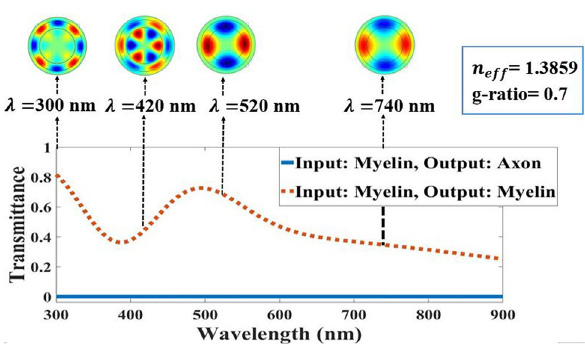
Figure 6. Light transmission spectra in output of the axon and myelin at g-ratio = 0.7 with guided modes in myelin sheath in 300 nm, 420 nm, 520 nm, 740 nm